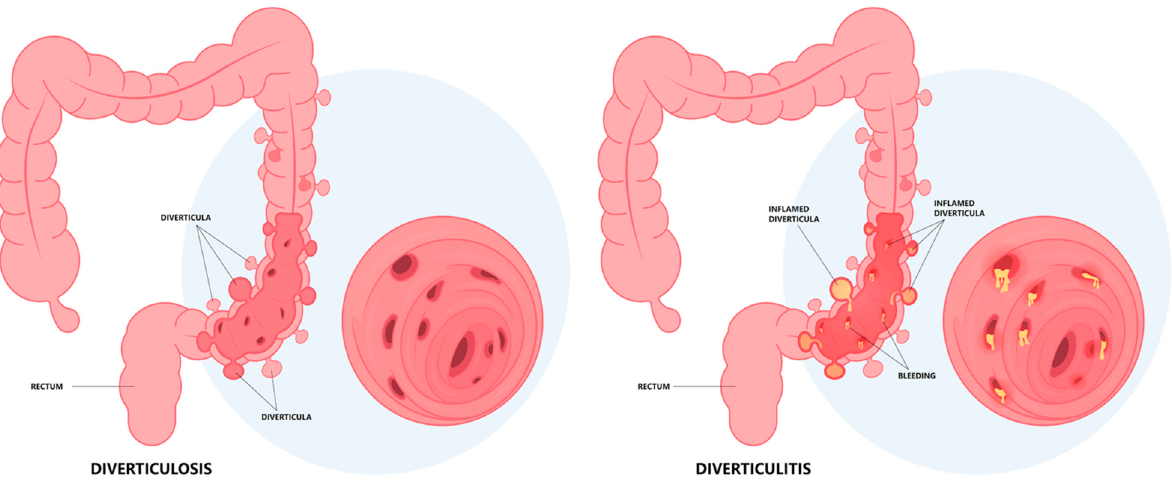
Figure 1. Diverticular disease is characterized by the presence of diverticula, which are small outpouchings in the lining of the colon. In most cases, diverticulosis is asymptomatic, but some people may experience changes in bowel habits such as constipation or diarrhea and vague abdominal symptoms that in same rare cases can resemble acute appendicitis, in a condition referred to as acute diverticulitis.